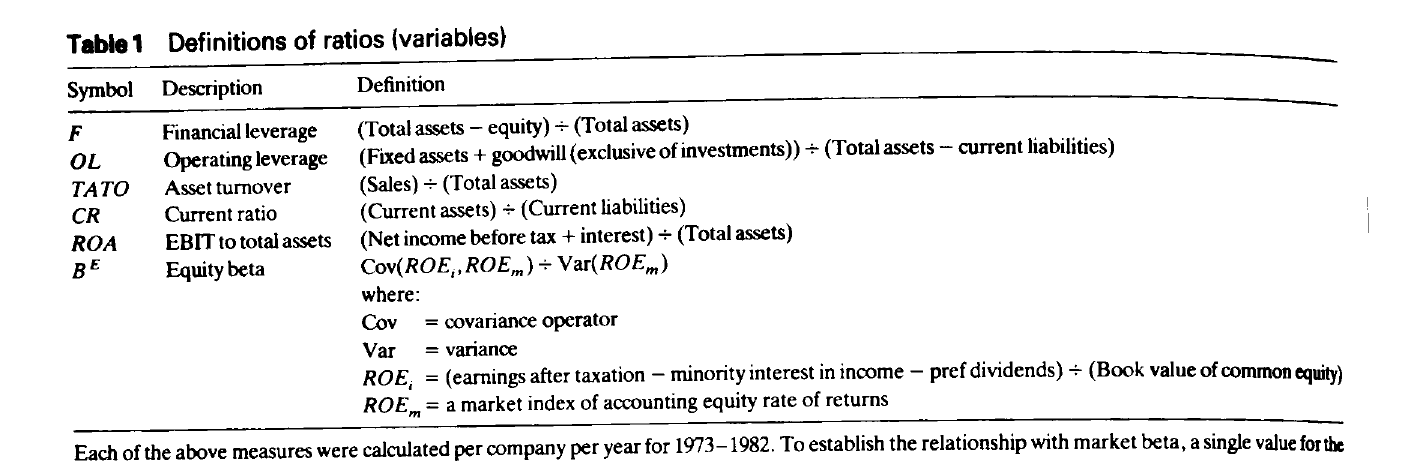
Table 1 Definitions of ratios (variables)